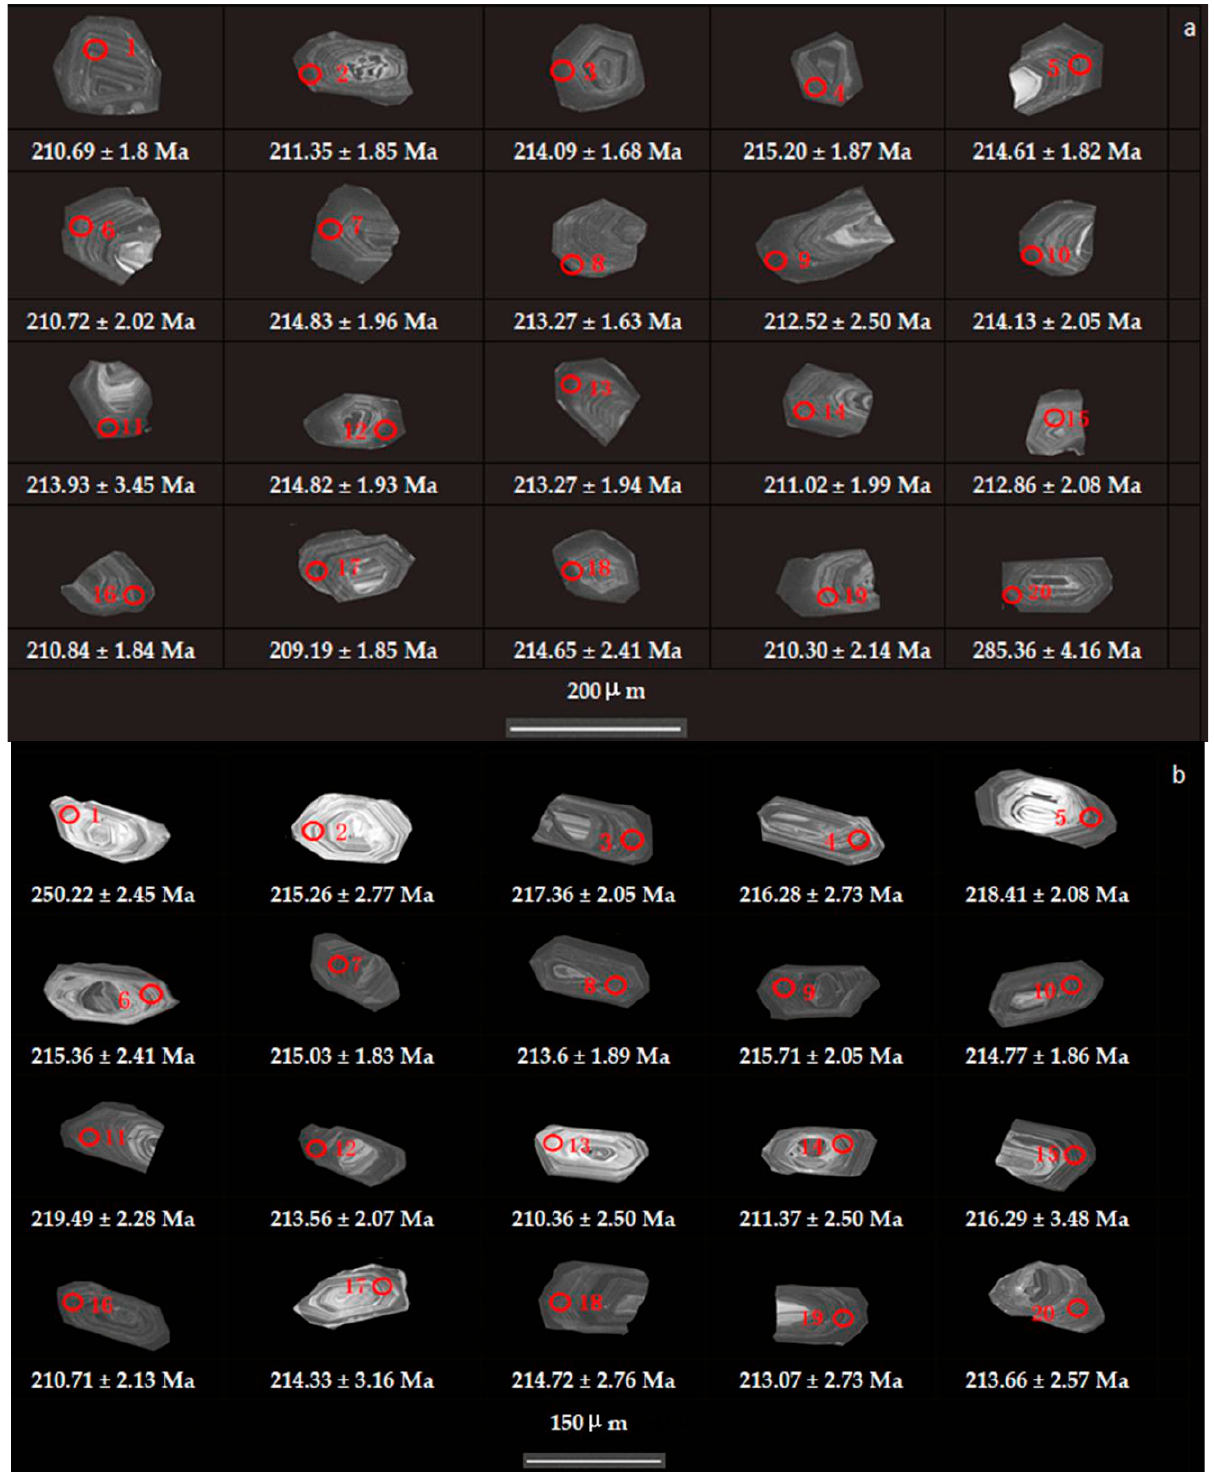
Figure 7. Cathodoluminescence images of selected ( a ) biotite granodiorite (sample P25-08TW01) and ( b ) biotite monzogranite zircons (sample P25-12TW). Solid circles indicate analytical spots used for U–Pb dating.